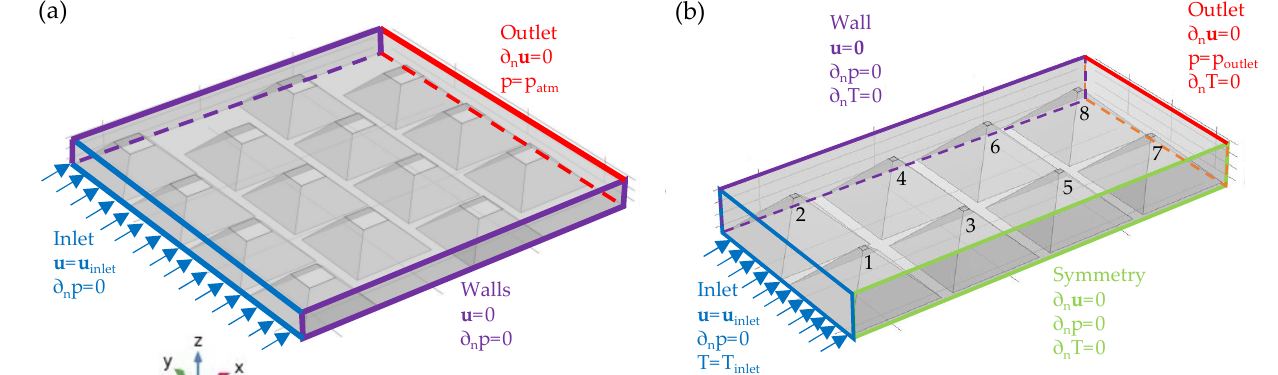
Figure 5. Boundary conditions for the PCM–air heat exchanger model: ( a ) steady-state incompressible flow for the assessment of pressure drop across, ( b ) coupled transient conjugate heat transfer and incompressible flow for assessment of thermal performance. The numbers identify individual pouches in order to track the evolution of the PCM within a given pouch.